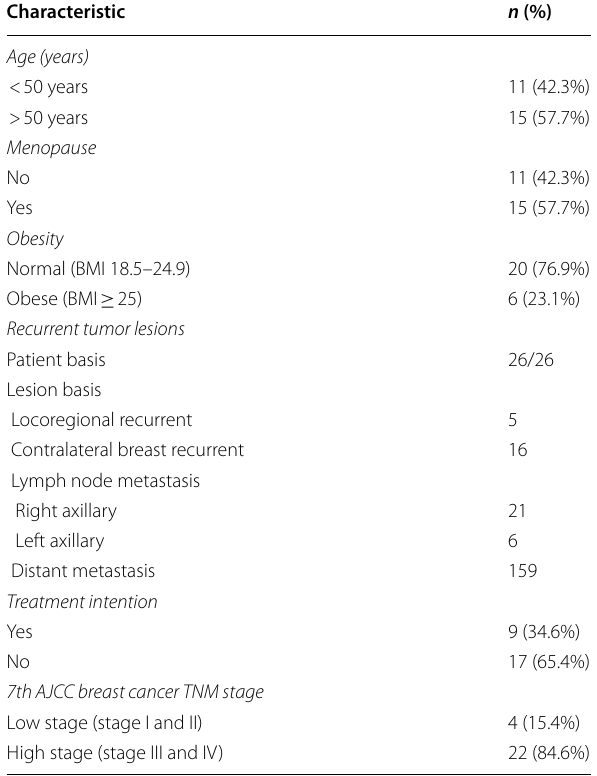
Table.2 Patient characteristics ( n 26) Table.3 Correlation between mean SUVmax and TNM =